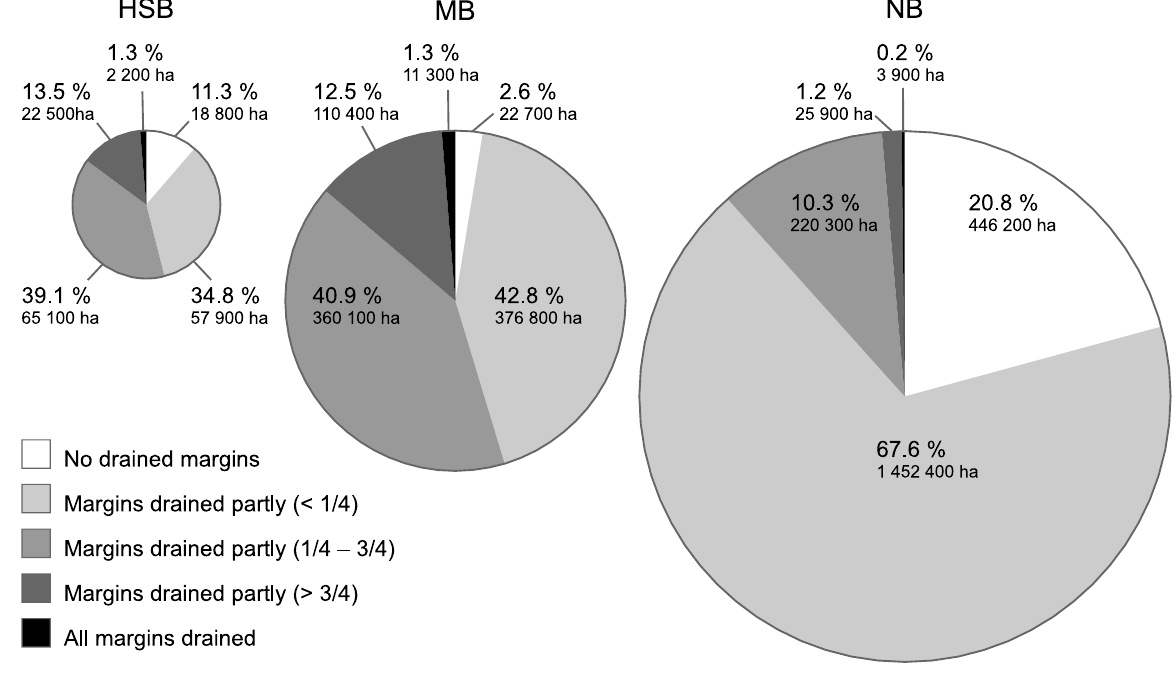
Figure 7. Undrained peatland area of Finland classified according to margin drainage. Peatland patches less than 1 ha in size are excluded, which explains the difference between the totals in this figure and those in Figure 5. HSB = hemiboreal and southern boreal zone, MB = middle boreal zone, NB = northern boreal zone. Table 5. Average margin drainage status (%) of large (> 50 ha) undrained peatland patches with aapa features and without